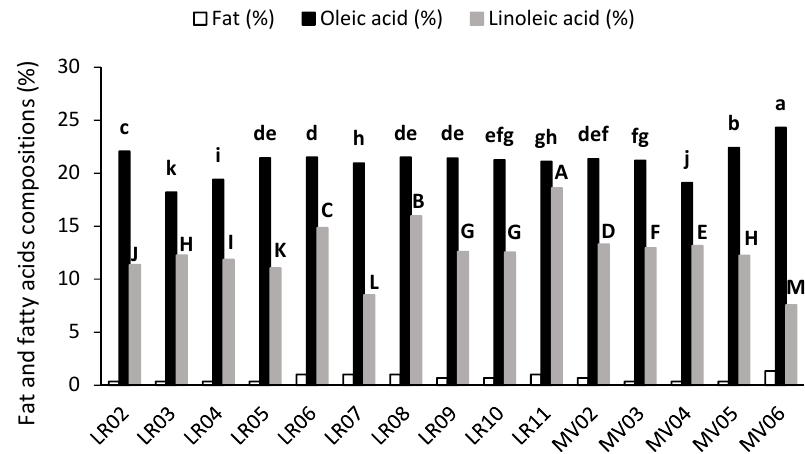
Figure 2. Fat and fatty acids compositions of landraces and modern varieties. Upper-case letters compare the beans for linoleic acid (gray bars), whereas lower-case letters for oleic acid (black bars). Means followed by the same upper- or lower-case letters are not significantly different (DMRT; p < 0.05).